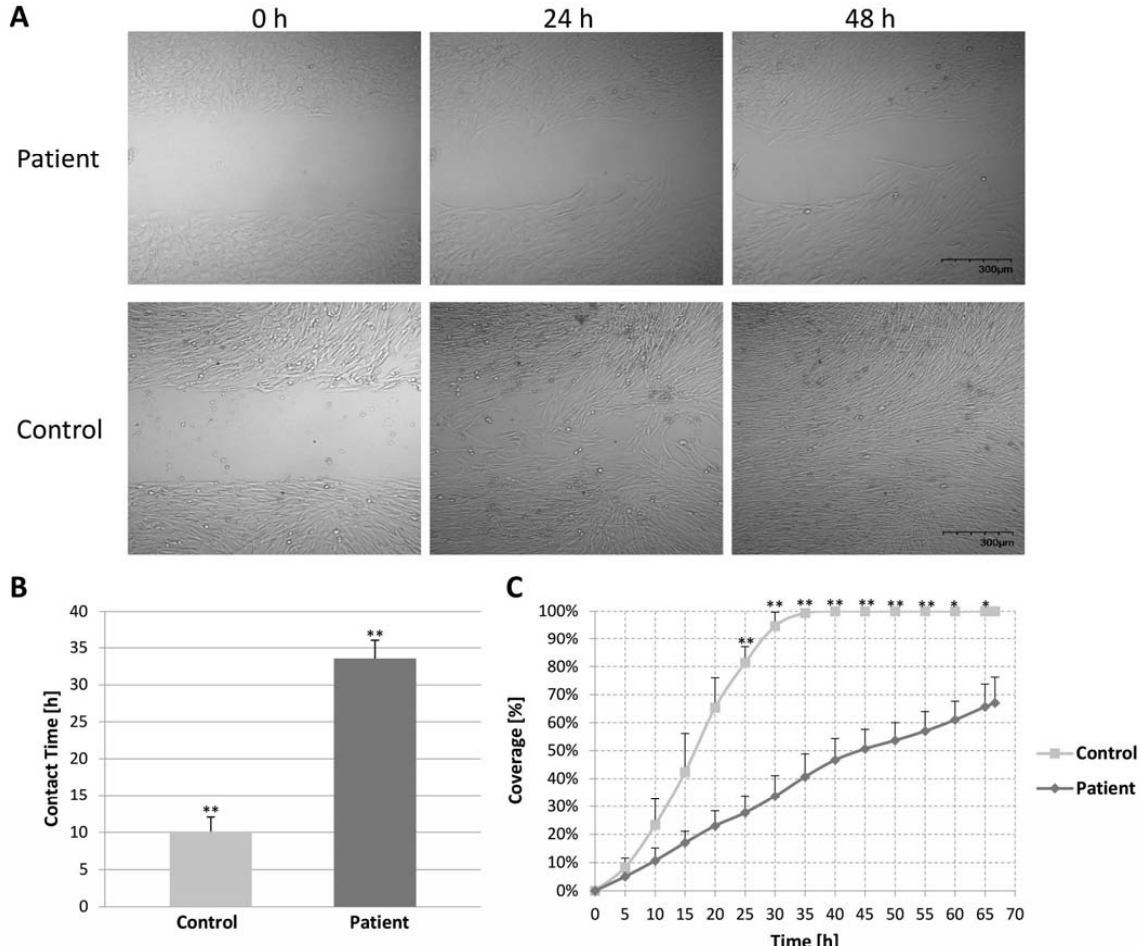
Figure 5. Wound healing assay assessing control and patient fibroblasts’ migration and plate coverage. Fibroblast movement was monitored using a time-lapse every 20 min for 67 h by a live-cell microscope. ( A ) Images of the control and patient’s fibroblasts were taken after removing the ibidi culture-insert 2 wells at 0, 24, and 48 h. ( B ) Migration time over the gap was determined by measuring the contact time of the cells from each side of the gap. The patient’s fibroblast cells noticed a significant increase in contact time. ( C ) Coverage was calculated by dividing each microscope figure into nine squares and measuring the area covered by the cells in each square. The results represent the means of all squares. The coverage was calculated at intervals of 5 hrs. There was a significant time difference in which the cells covered the plate. All results are representative of three independent experiments. Error bars are SD. * p ≤ 0.005, ** p ≤ 0.001.